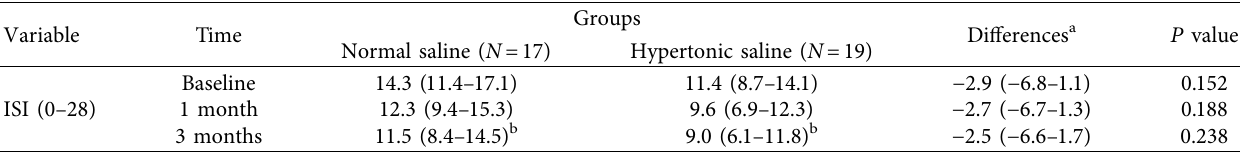
Table 3: Changes in the estimated insomnia severity index after epidural block with or without hypertonic saline in patients with postherpetic